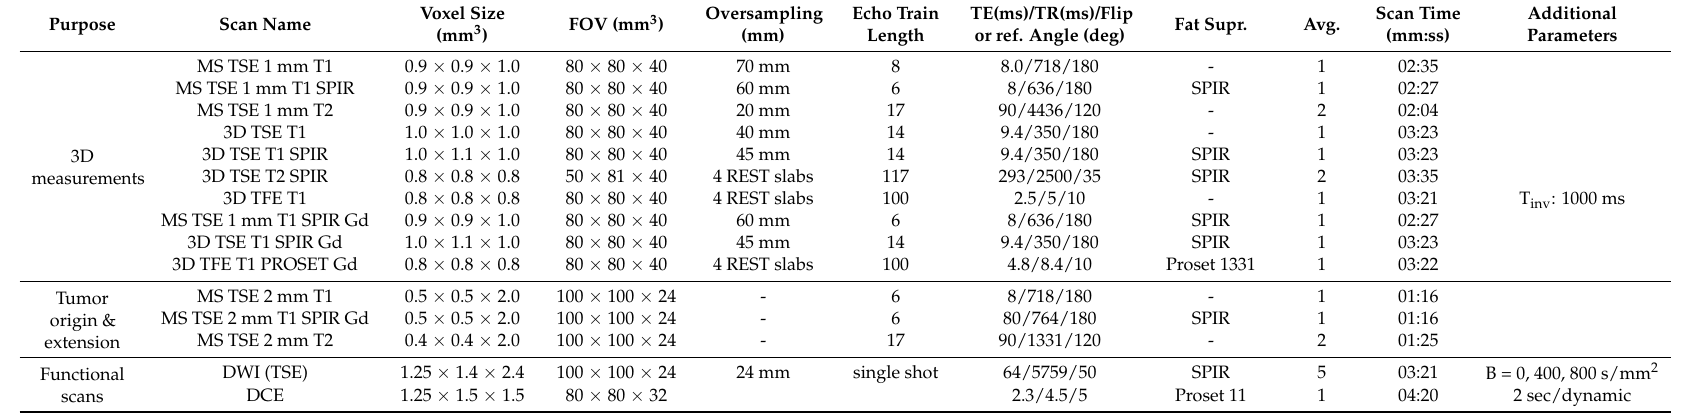
Table 2. Scans’ parameters of the anatomical and functional sequences from the Study Protocol and of the 3D TSE T1 SPIR, the latter not part of the Study Protocol, but lately added to the Clinical Protocol. Both the multi-slice (MS) 2 mm and the diffusion-weighted imaging sequences are planned perpendicular to the tumor, using the 3D scans as a reference. During the Dynamic Contrast-Enhanced (DCE) scan, the contrast agent is administered and afterwards the contrast-enhanced (Gd) scans are